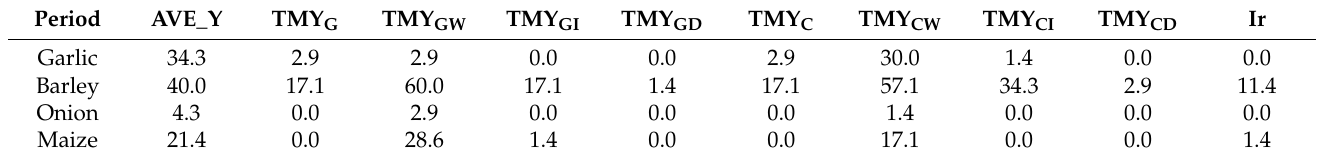
Table 6. Percentage of years in which the crop suffered excessive stress caused by water deficit